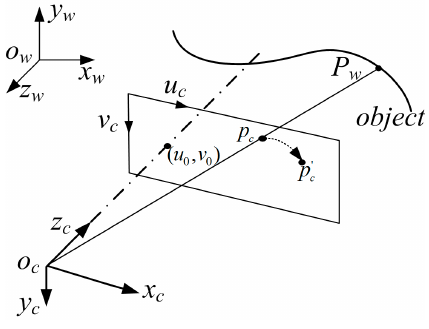
Figure 2. Pinhole camera model.